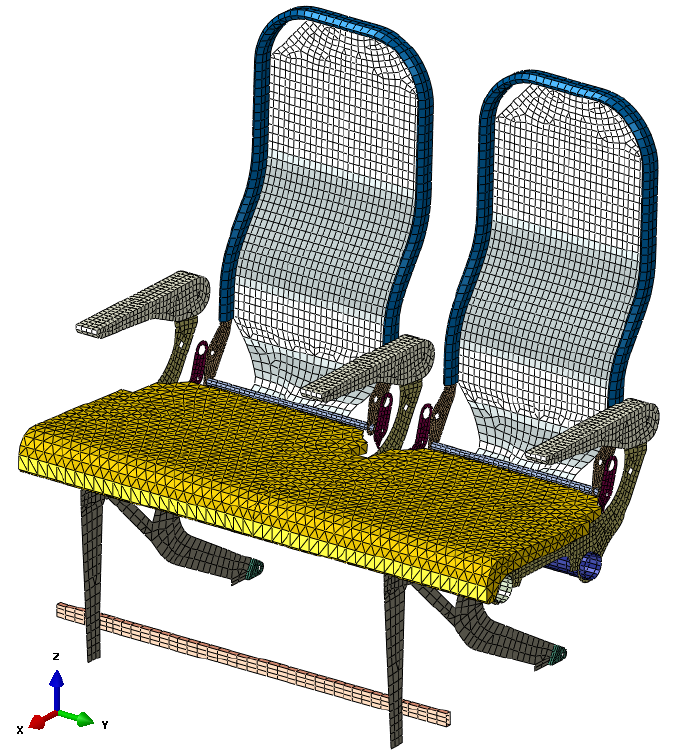
Figure 2. CAD model of two aircraft seats.